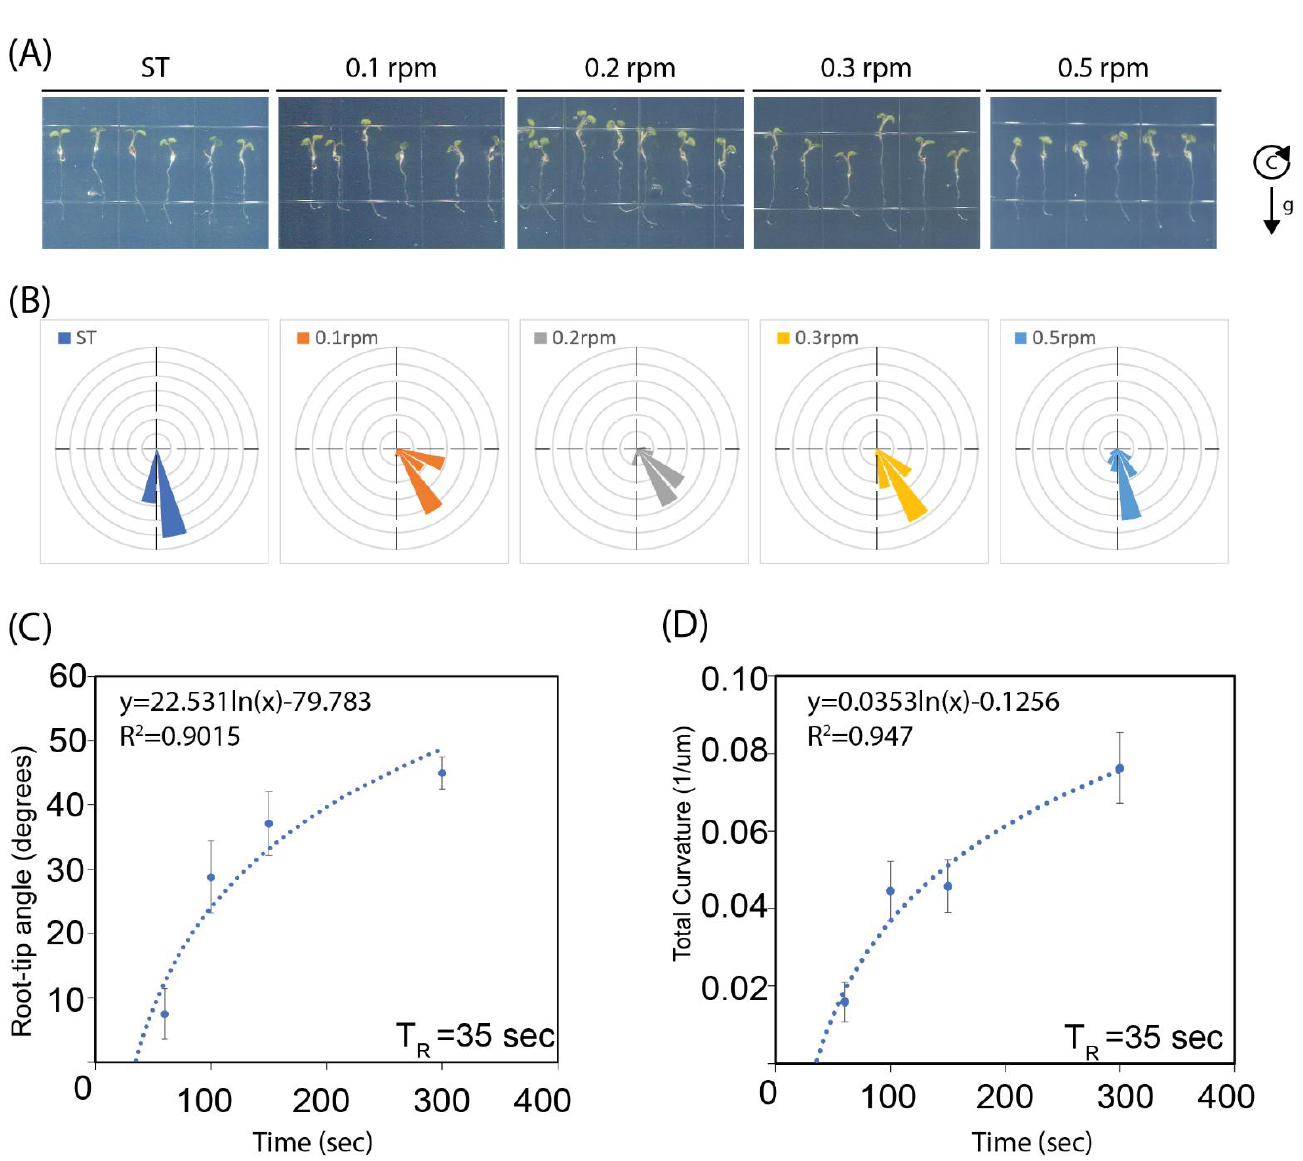
Figure 3. The speed of clinorotation affects the level of root tip curvature: ( A ) Representative root tip images of Arabidopsis seedlings clinorotated clockwise at the indicated speeds (0.1, 0.2, 0.3, and 0.5 RPM) and stationary growth (ST) in darkness for 18 h. g c represents the gravity vector at the onset of clinorotation. ( B ) Rose plot of the root tip angles (in degrees) at the end of clinorotation at the indicated speeds. ( C , D ) Root tip angles in degrees ( C ) and total root tip curvatures ( D ) reached at the end of 18 h clinorotation as functions of the duration of the first half-turn of clinorotation (half periodicity, in s). Best-fit logarithmic models (dotted lines) are represented on these graphs, whose functions are indicated at the top along with the corresponding correlation values (R 2 ). The realization time (T R ) deduced from these functions is indicated at the bottom right of each graph. n = 20. This experiment was repeated twice, with similar results.